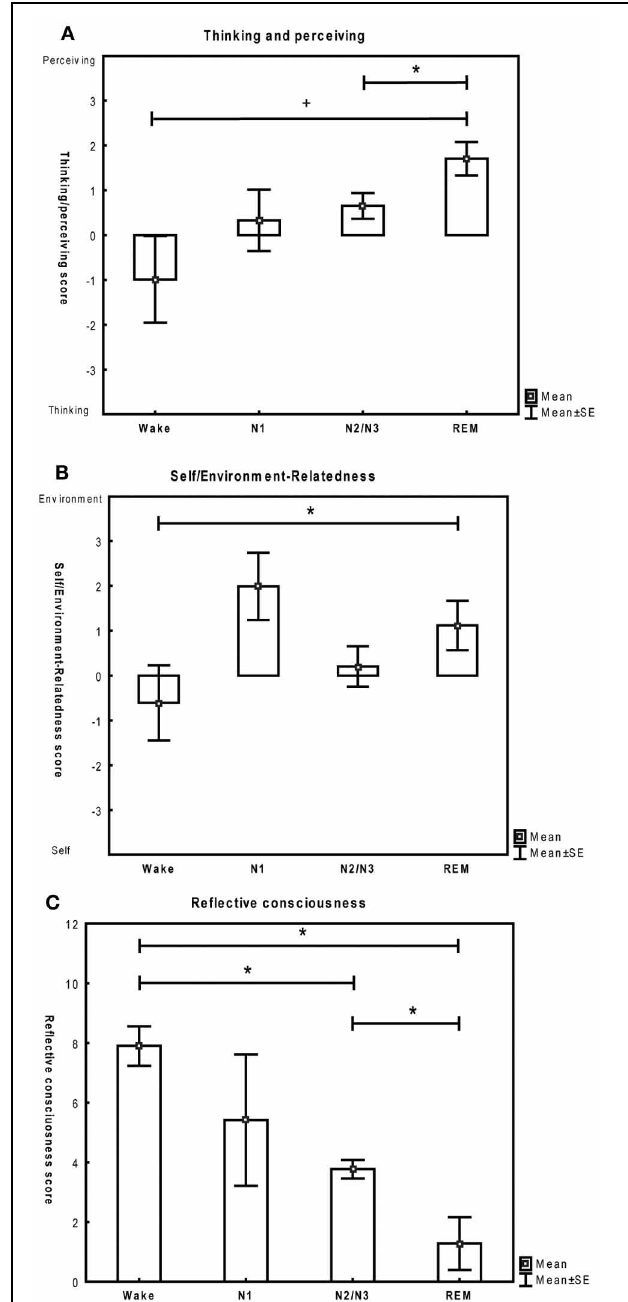
FIGURE 8 | (A–C) Qualitative features of conscious experiences across stages (mean and standard error). Paired t -tests. ∗ p < 0 . 05, + p = 0 .